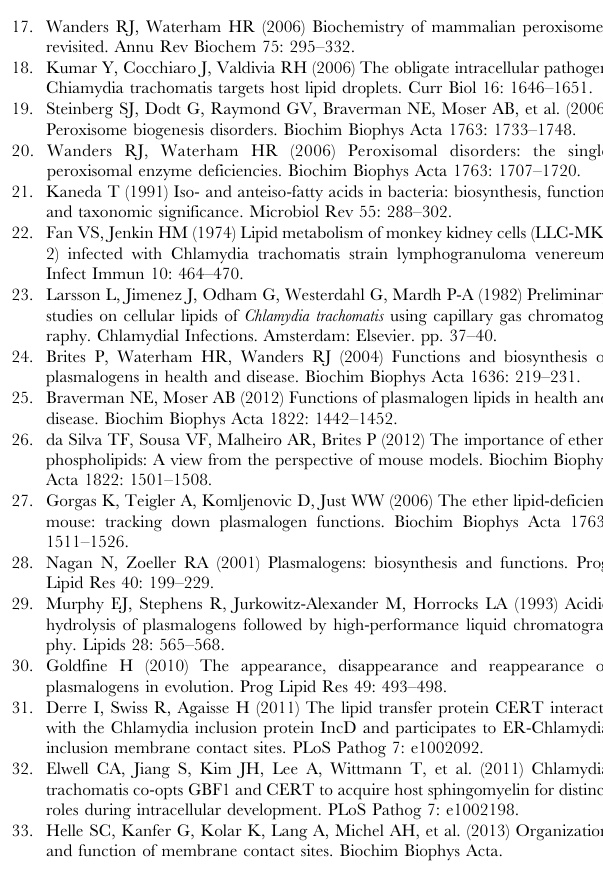
Figure S1 Lipid analysis: workflow and methods vali- dation.